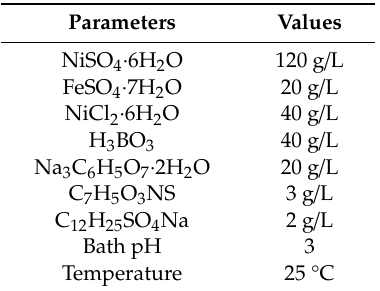
Table 1. Chemical composition of the electrolyte.